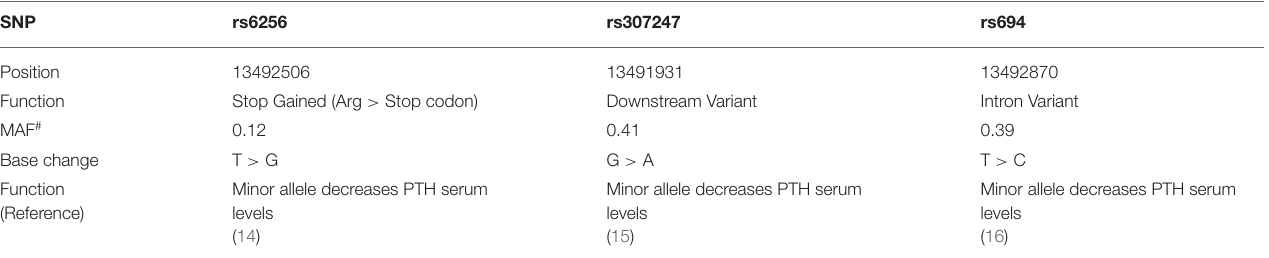
TABLE 1 | Characteristics of studied SNPs in PTH